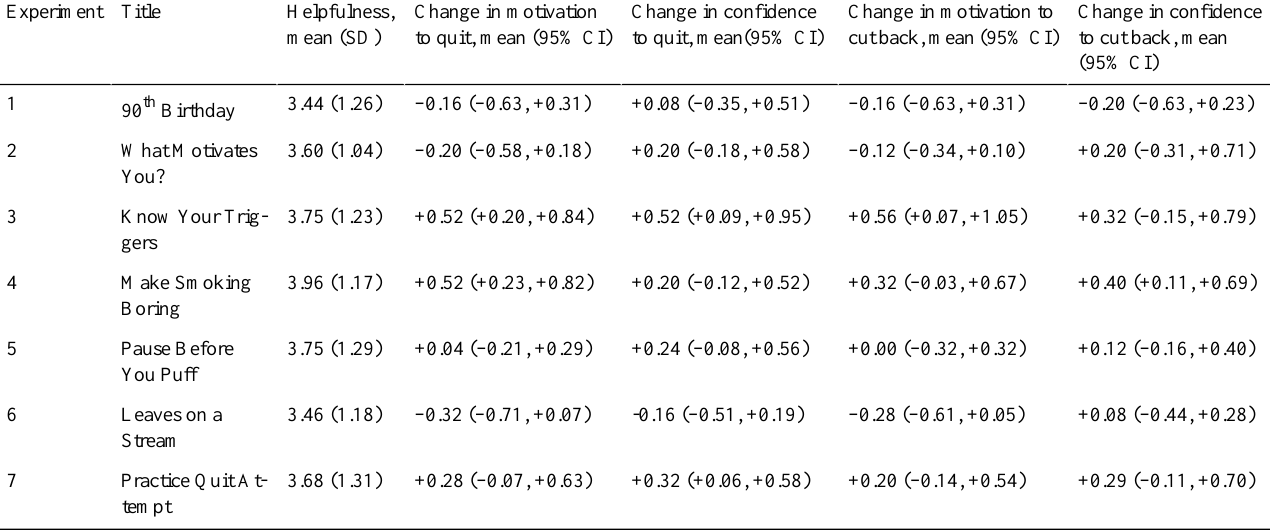
Table 2. Personal experiments and user receptivity outcomes.